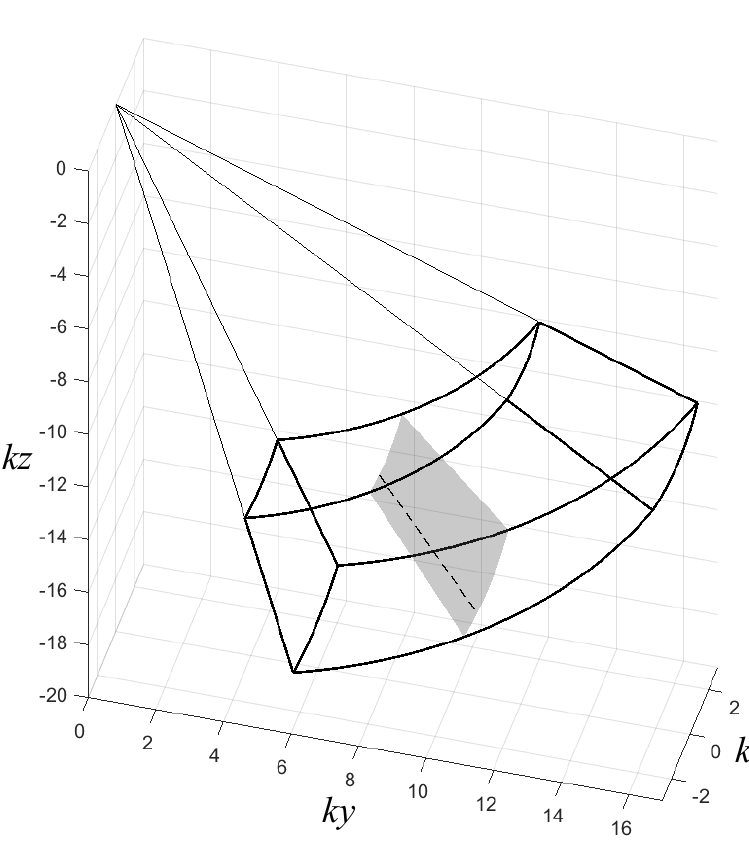
Figure 2. Geometrical loci associated with the wavenumbers illuminated by a typical airborne SAR system. A small target, observed from a fixed azimuth position, is associated with the dashed segment here shown: the distance from the origin being proportional to the radar central frequency, its length to the system bandwidth and its orientation following the segment connecting sensor and target (the local line-of-sight). The set of segments associated with every position of the sensor within the synthetic aperture is shown as a gray surface. The set of patches associated with all the off-nadir angle ϑ explored by the physical antenna gives rise to the volume whose edges are shown as thick